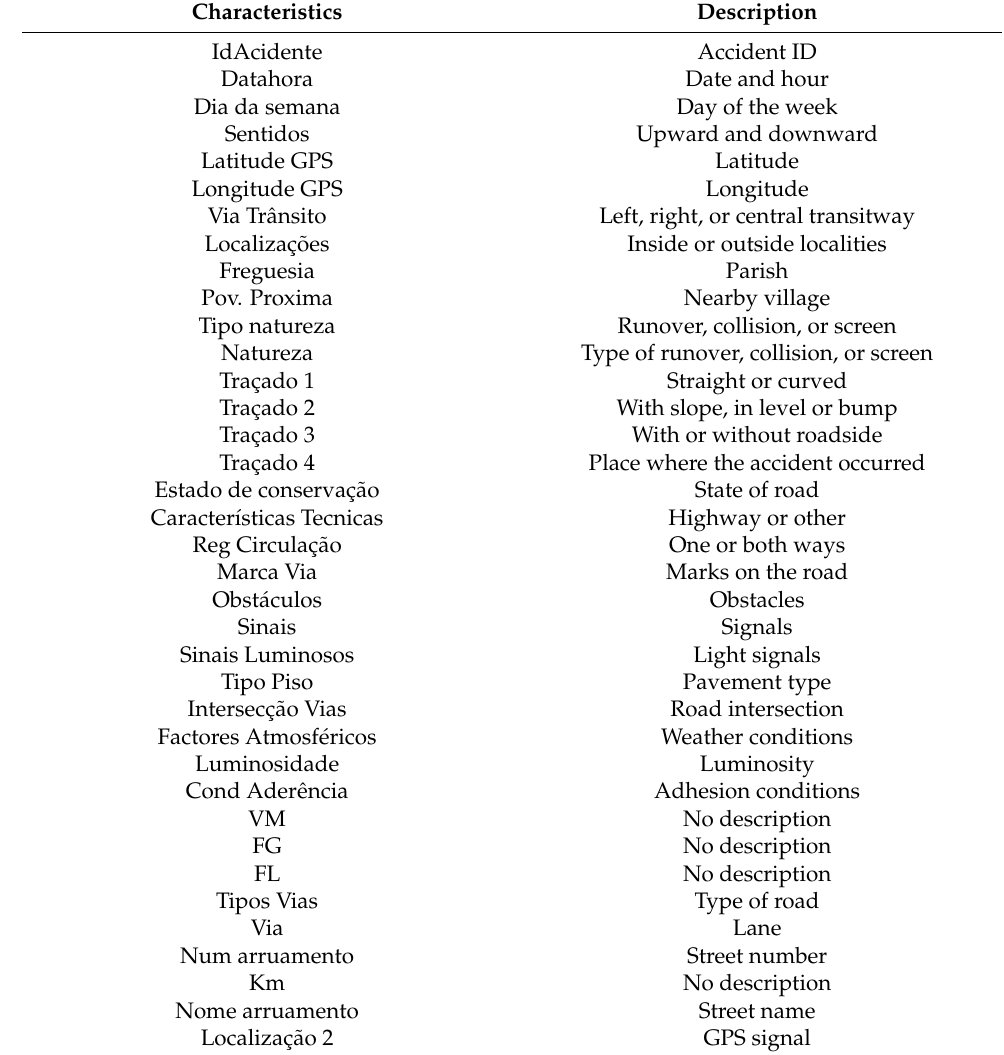
Table 3. Accident data schema.